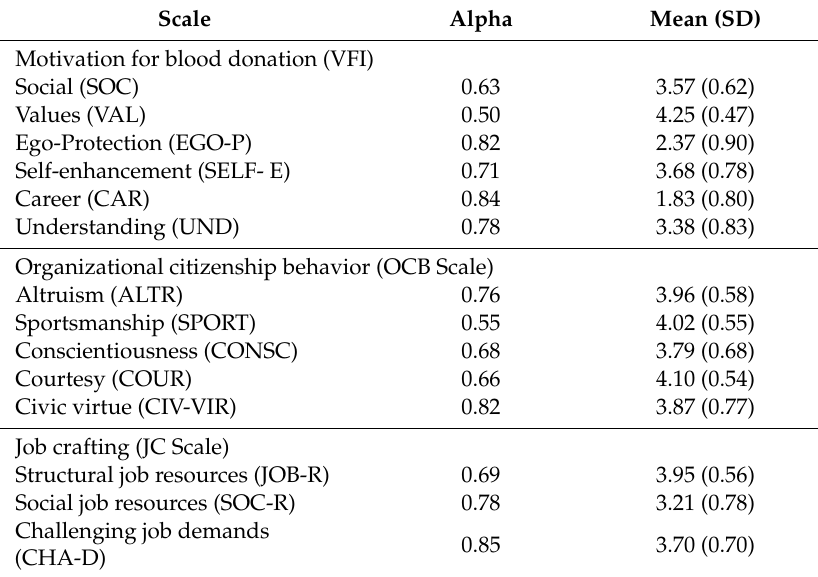
Table 1. Descriptive statistics of the total scale scores of the three VFI, OCB and JC